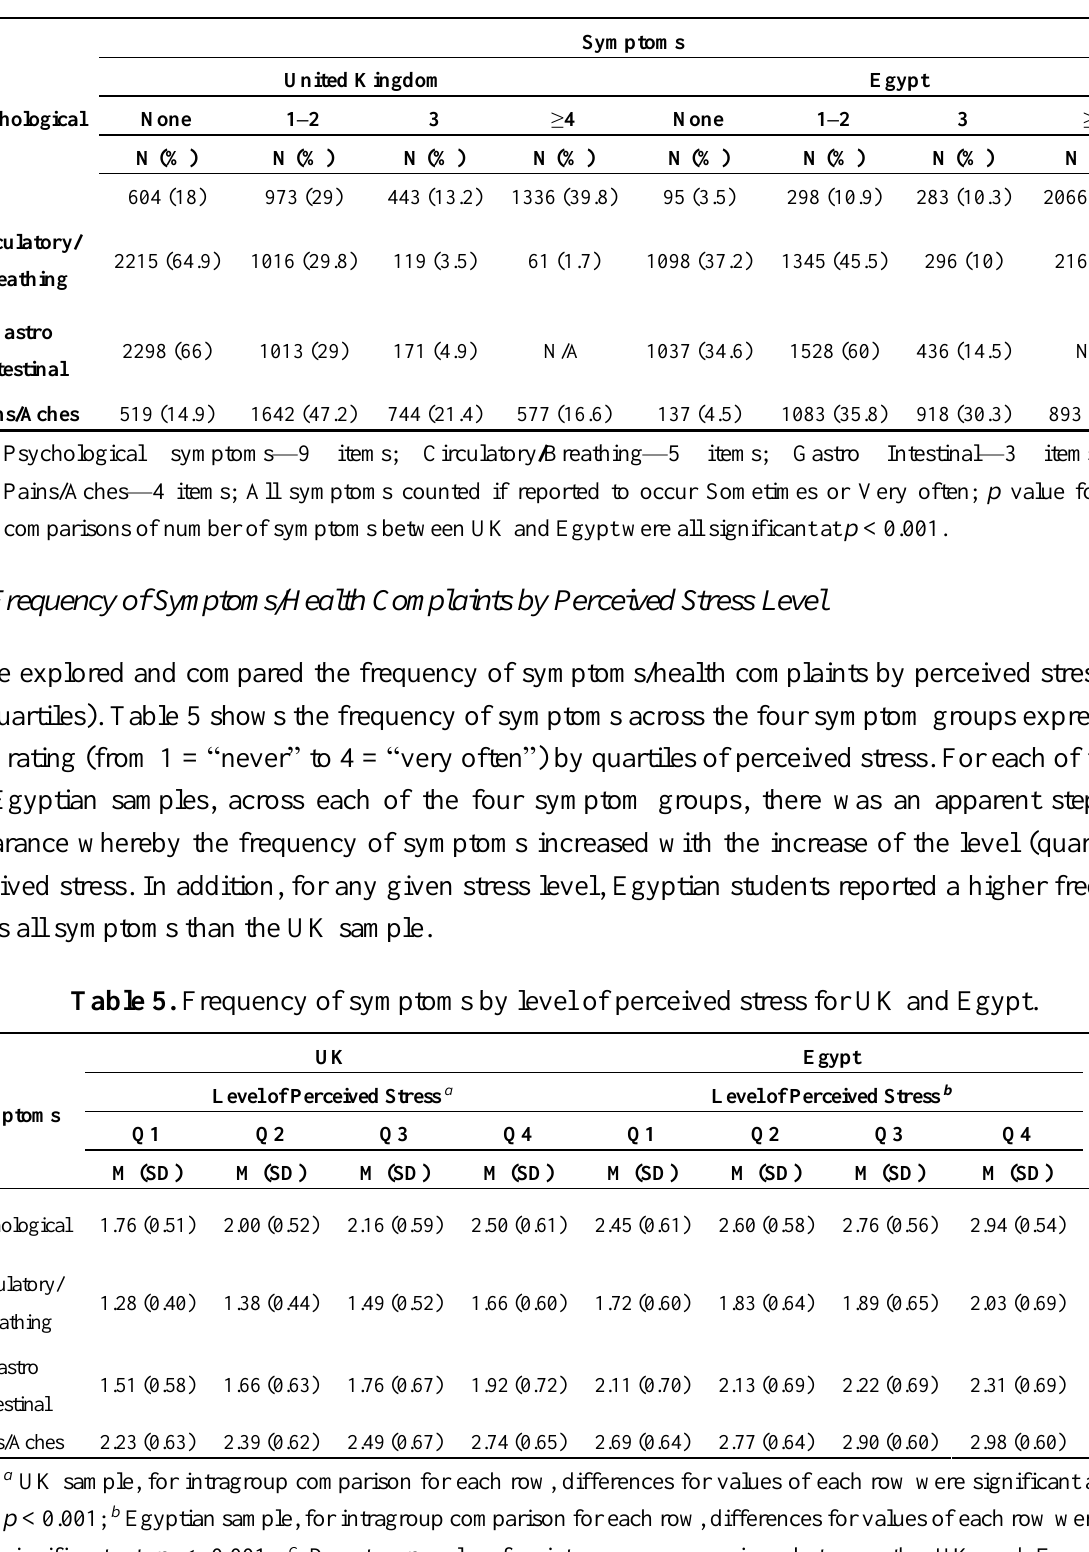
Table 4. Number of symptoms/health complaints reported in last 12 months.